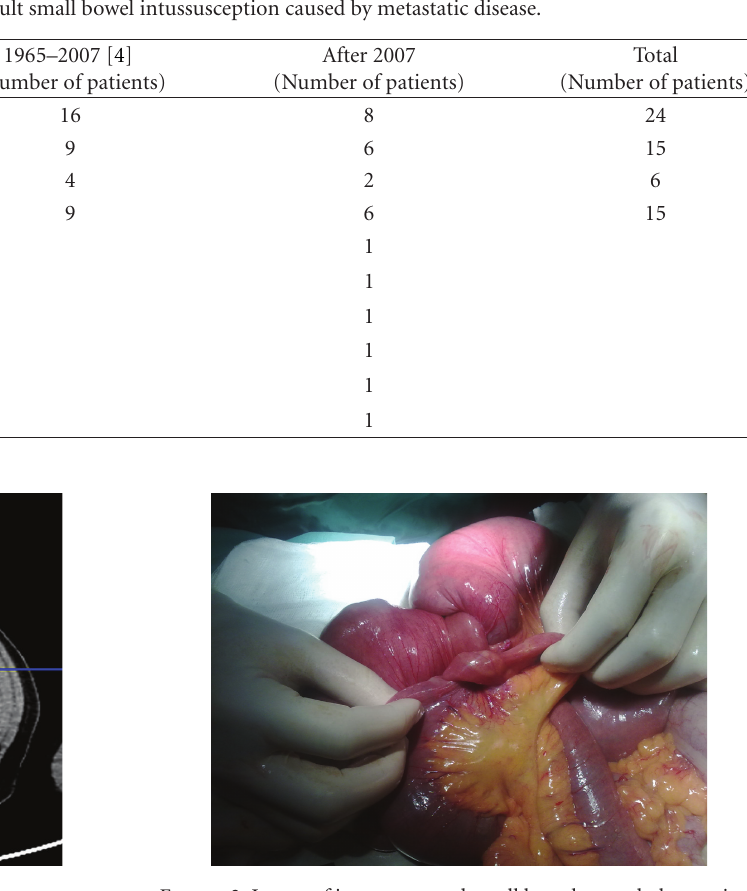
Figure 2: Image of intussuscepted small bowel caused obstructions in two di ff erent segments and dilated small bowel